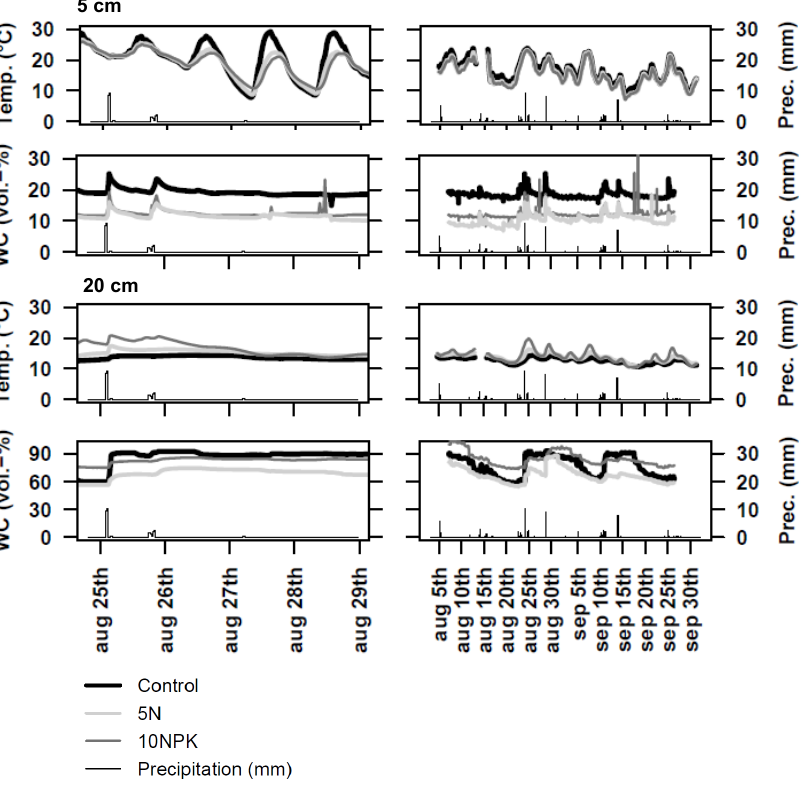
Fig. 2. Time series of soil temperatures and volumetric water contents in 2 depths for a short time span (left side) and the whole measurement period (right side). Additionally, precipitation is